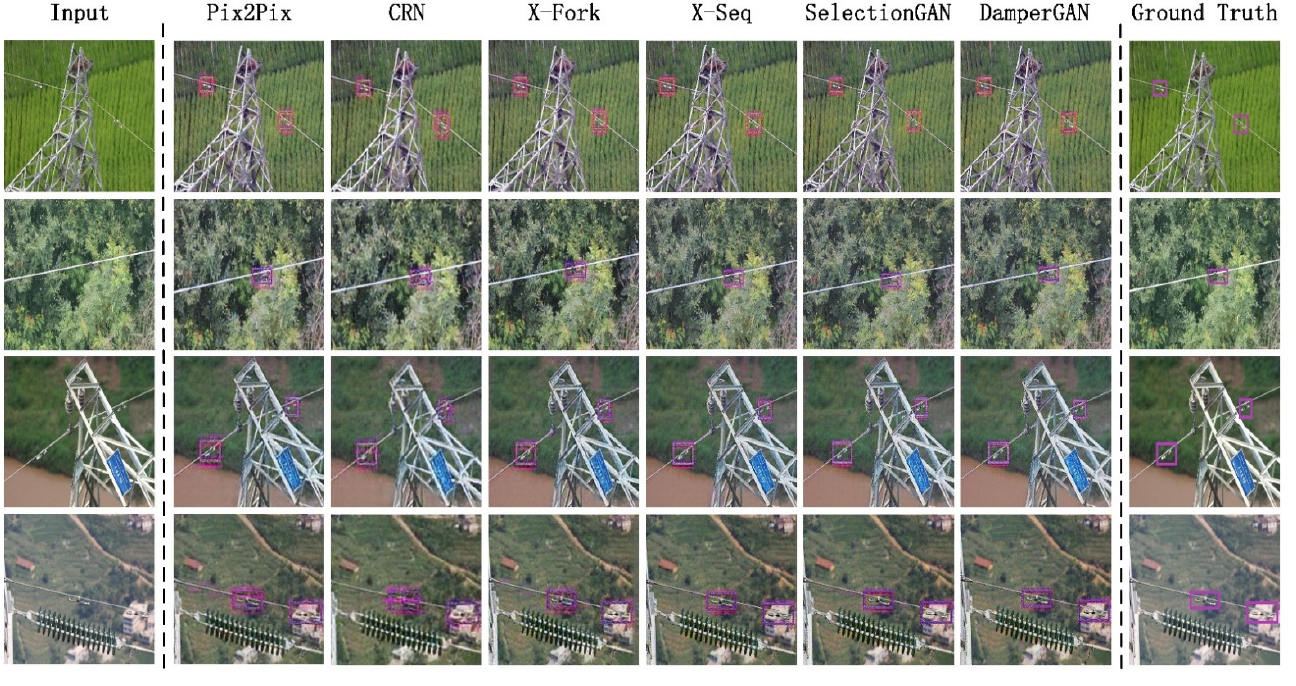
Figure 5. Test examples of each model on the DamperGenSet dataset.